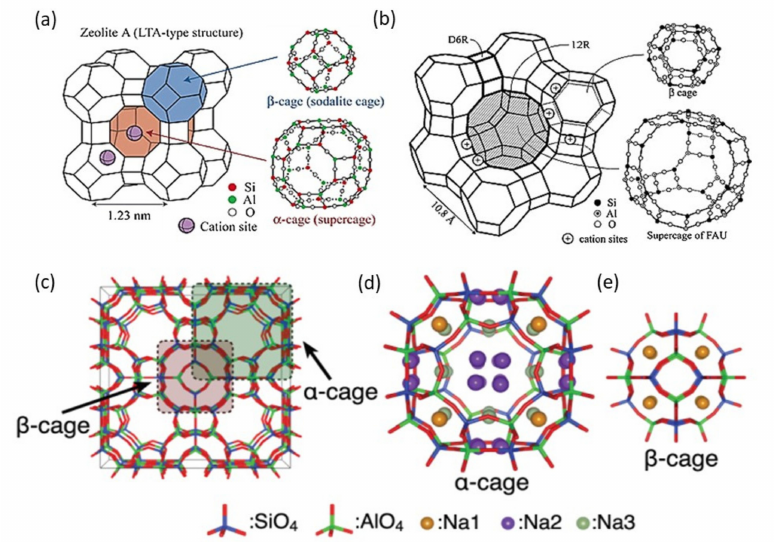
Figure 6. Different types of zeolite frameworks: ( a ) LTA type and ( b ) FAU type of zeolites’ framework structures; ( c ) NaA type of zeolite’s crystal structure in (100)-projection; ( d ) schematic diagram of α -cage and ( e ) β -cage. Adapted with permission from ref. [94,95]. 2017, 2013 Elsevier, Nature. The work, ref. [95] is licensed under a Creative Commons Attribution-NonCommercial-NoDerivs